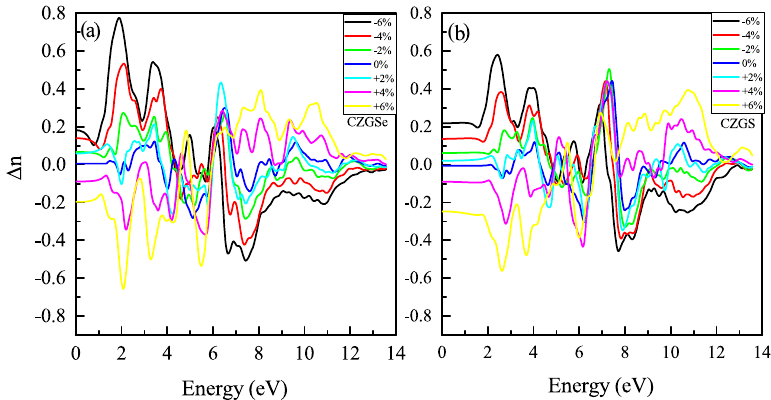
Figure 15. Spectral behavior of the birefringence for CZGS and